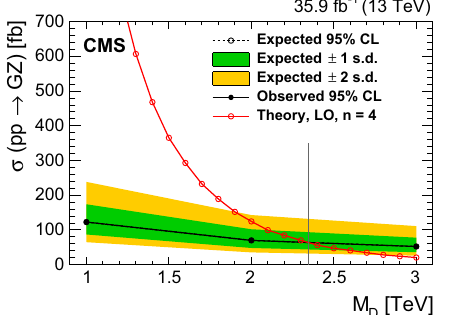
Fig. 10 The 95% CL upper limits on the Wilson coefficient λ/Λ d U of the unparticle-quark coupling operator. The results from an earlier CMS search in the same final state [39] are shown for comparison